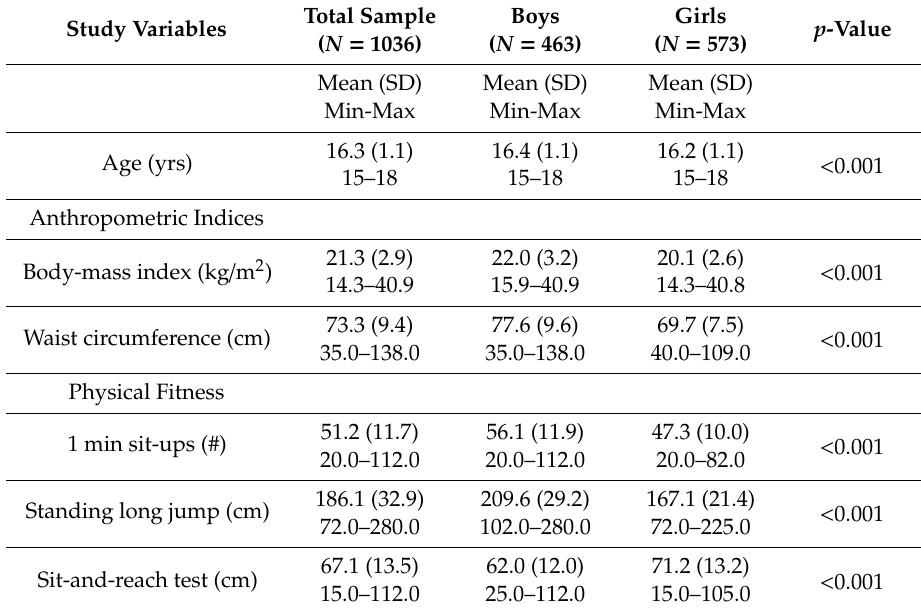
Table 1. Basic descriptive statistics of the study participants, (Croatia,